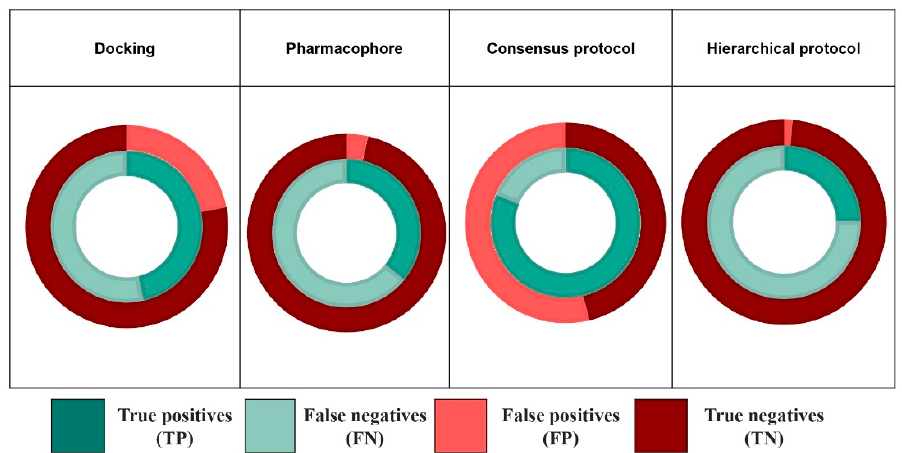
Figure 6. Pie charts illustrating the performance of each individual model (docking and pharmacophores) and the combination of both using the consensus and the hierarchical protocol.